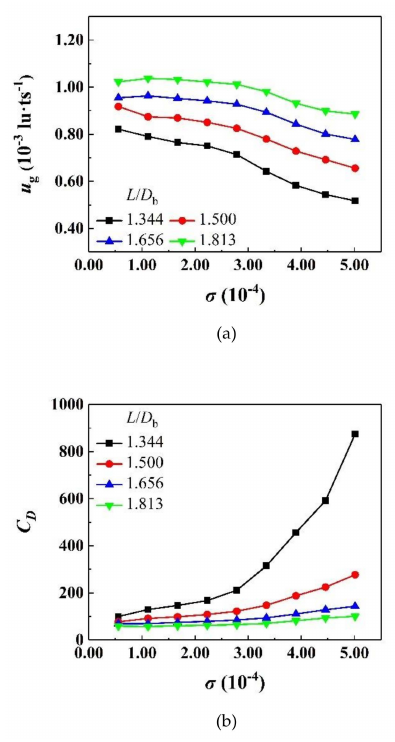
Figure 10. Variations of u g ( a ) and C D ( b ) with surface tension at Re Gr = 100 and Eo =